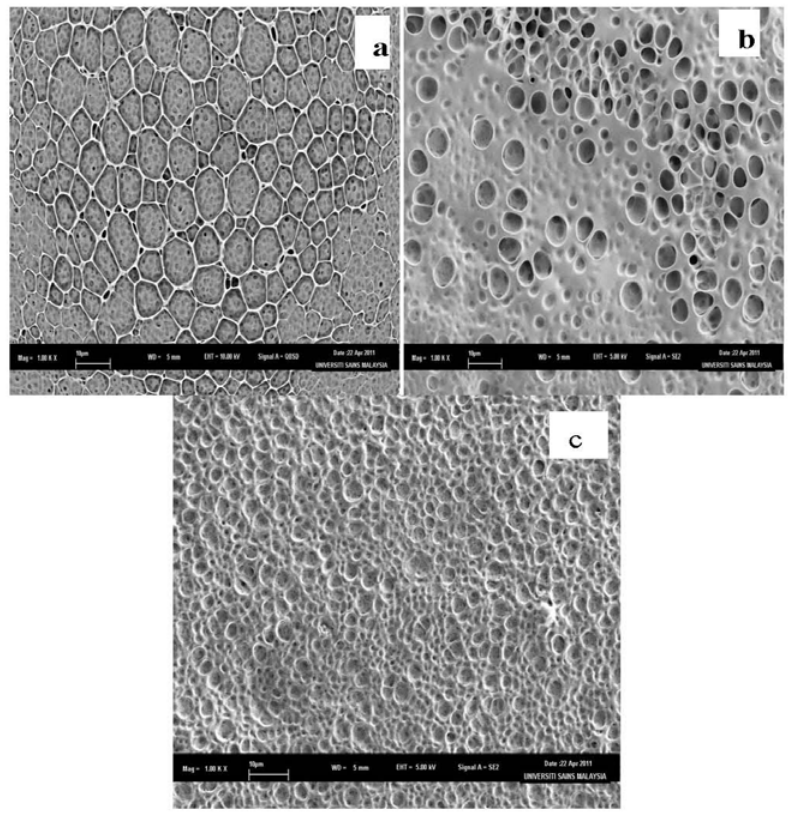
Figure 4. FESEM of ( a ) 40 mg PVC:1 mg DMABET; ( b ) 40 mg PVC:1 mg DMABET:80 mg BEHS and ( c ) 40 mg PVC:1 mg DMABET:80 mg BEHS:0.7 mg KTClPB membranes (1000×